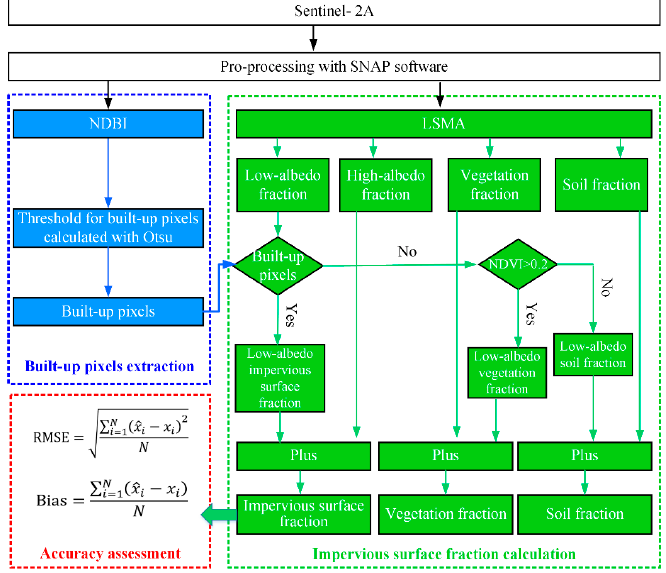
Figure 2. Flow chart for the extraction of impervious surface fraction in this study. LSMA: linear spectral mixture analysis; NDVI: normalized difference vegetation index; NDBI: normalized difference built-up index.